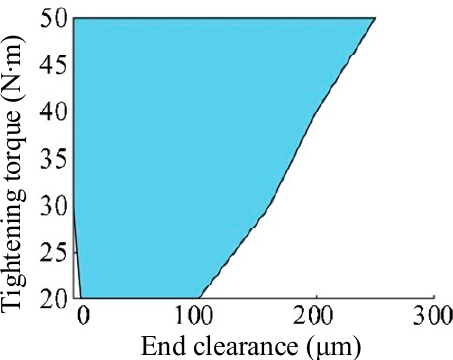
( b ) Figure 10. Effect of tightening torque on contact pressure of the spindle–GWF interface: ( a ) effect of tightening torque on tapered contact pressure of interface; ( b ) effect of tightening torque on end contact pressure of interface. According to the geometric relationship between the tapered surface and the end face of the spindle–GWF interface, the relationship between the taper clearance u t and the end